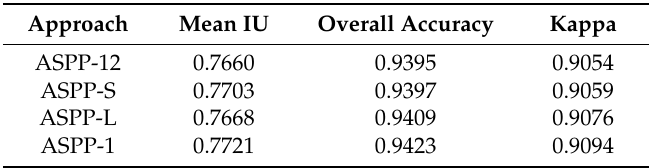
Table 6. Experimental results of ASPP.